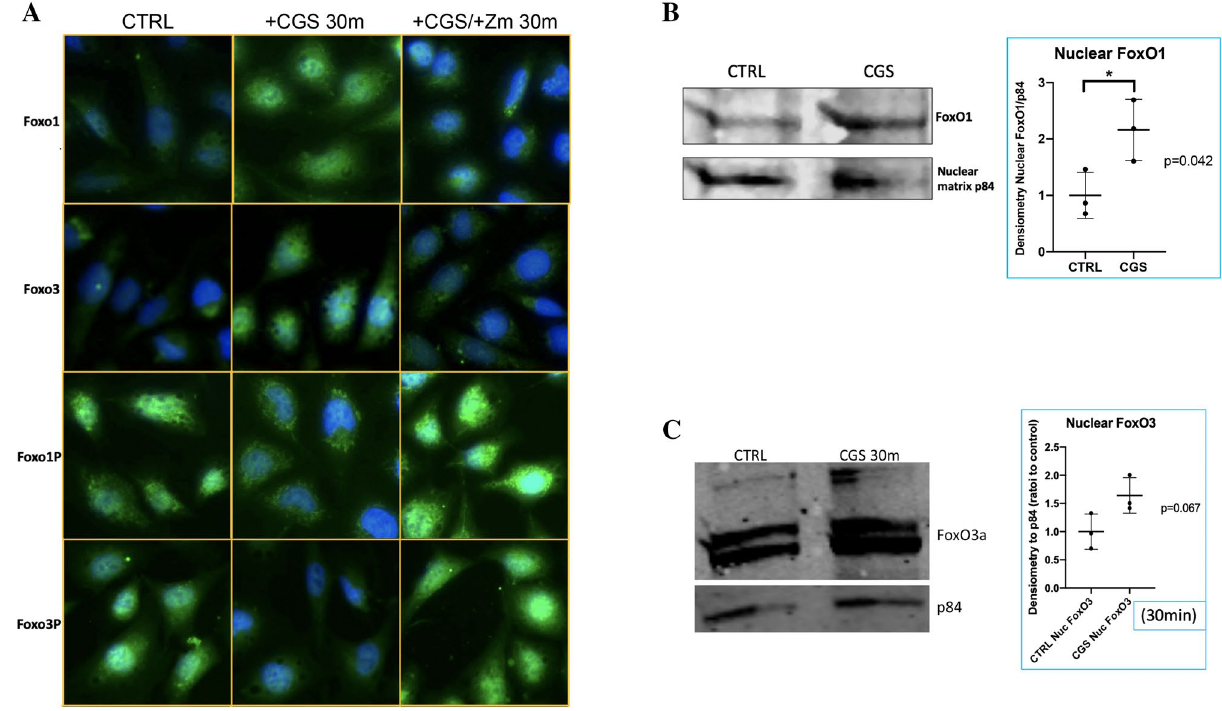
Figure 1. A2AR binding promotes FoxO1 and FoxO3 nuclear translocation and significant increase in nuclear FoxO1 levels. ( A ) Different groups of TC28α2 cells labeled as CTRL (untreated chondrocytes), + CGS for 30 m (treated), and + CGS/ + Zm (pre-treated with the A2AR antagonist). FoxO1, FoxO3, FoxO1-P (Ser256), FoxO3-P (Ser253) are displayed in green by IF for these various cell conditions at 40 × hpf. These cell images were representative of 3–4 individual experiments for each antibody and condition. DAPI is in blue, and nuclear overlap appears aqua-bright or green in the nuclear compartment. ( B ) Western blot of the nuclear fraction protein extract from TC28 ⍺ 2 human chondrocytes treated with or without 1 µM CGS for 30 m assessing FoxO1 protein levels with nuclear protein loading control nuclear matrix protein p84. Calculation of nuclear FoxO1/p84 densitometry (normalized to nuclear control) in individual western blotting experiments with